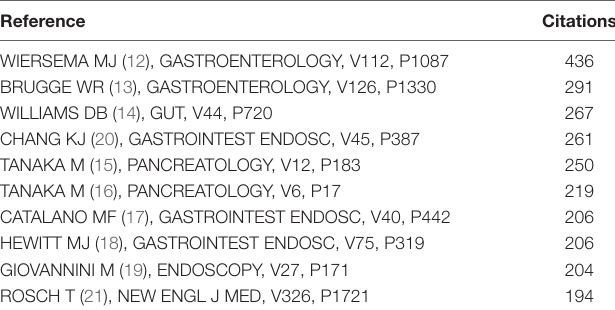
TABLE 4 | The top 10 most frequently cited references of EUS